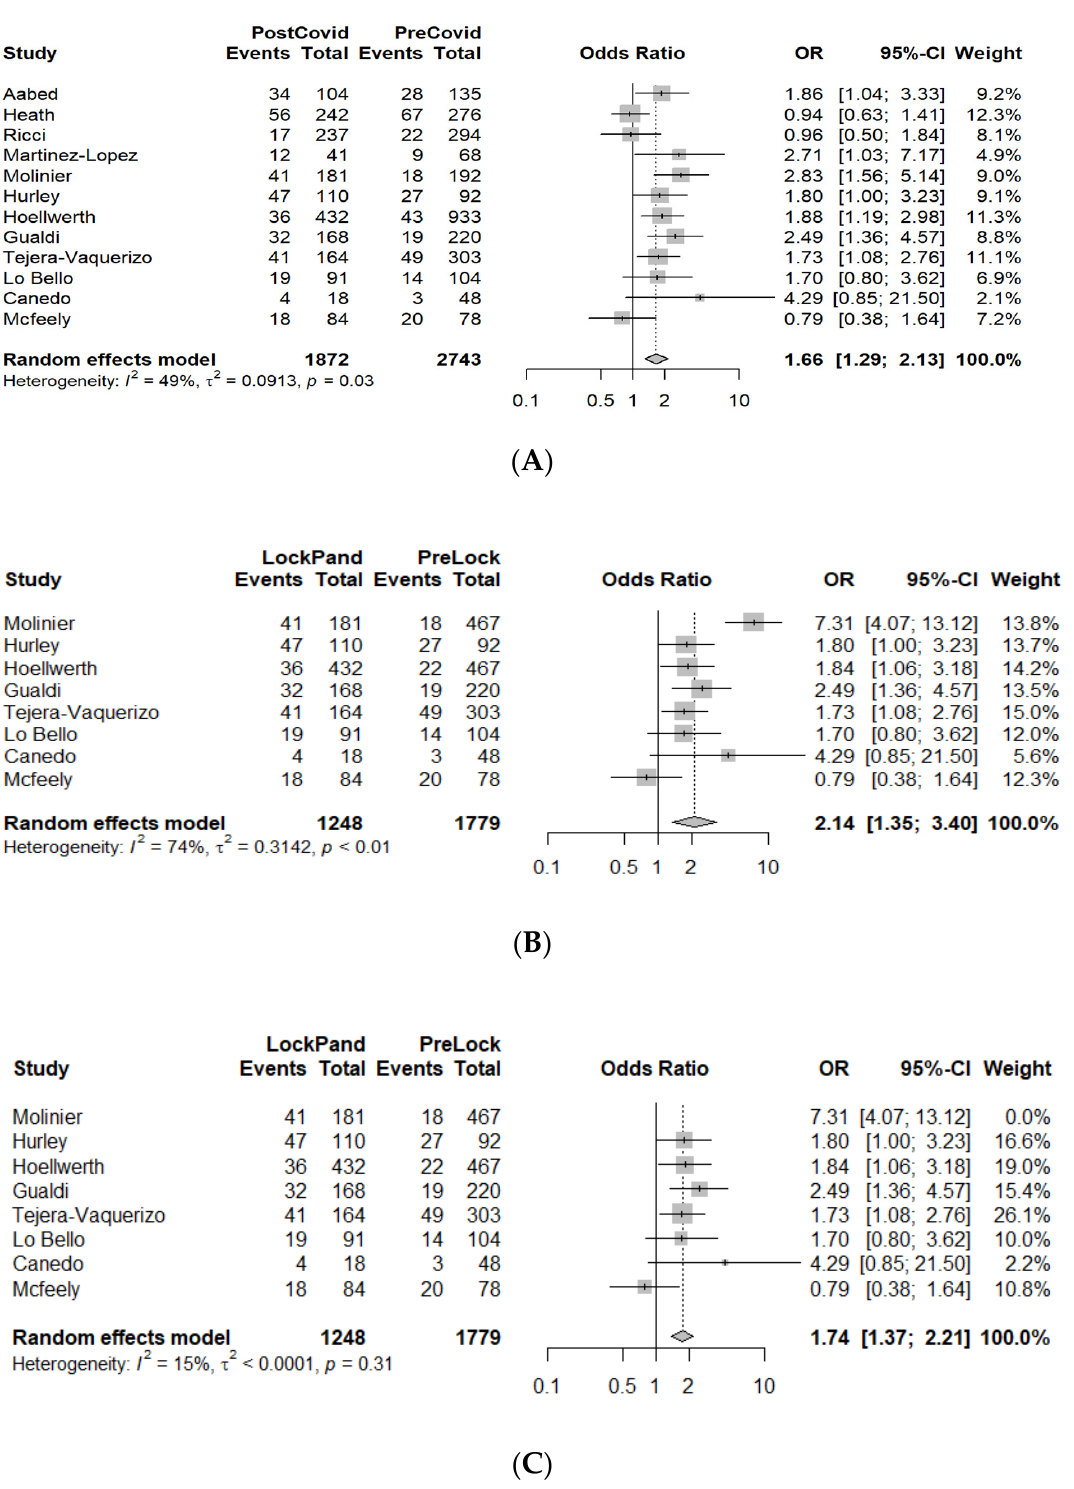
Figure 3. ( A ). Forest plot of ulceration rates for the PreCovid and PostCovid groups. ( B ). Forest plot of ulceration rates for the PreLock and LockPand groups. ( C ). Forest plot of ulceration rate sensitivity analysis results for the PreLock and LockPand groups.